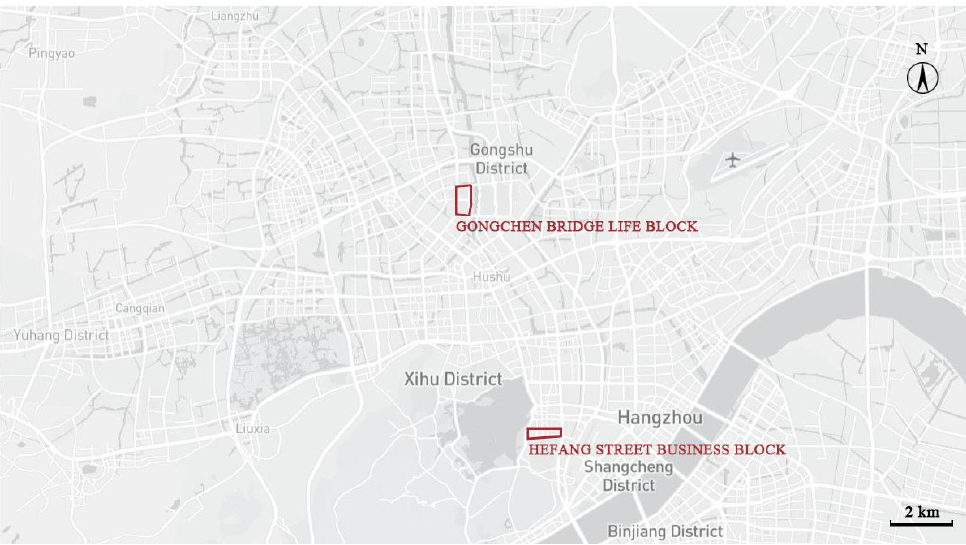
Figure 2. Location map of Hefang Street business block and Gongchen Bridge life block (according to Baidu map).